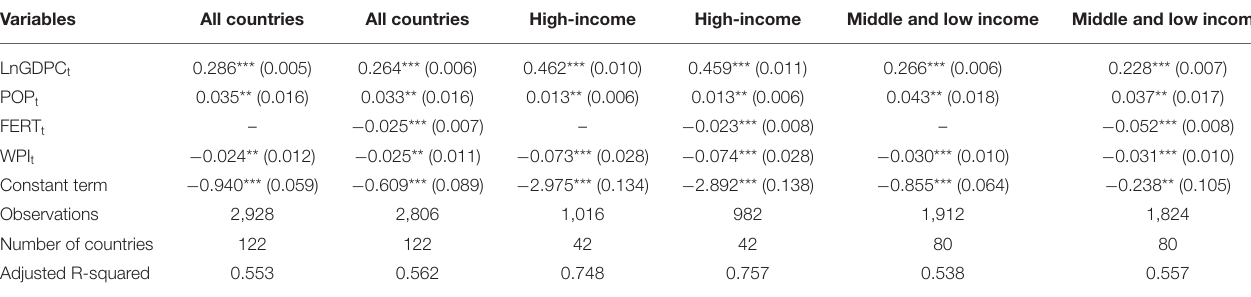
TABLE 4 | Panel data fixed-effects estimation